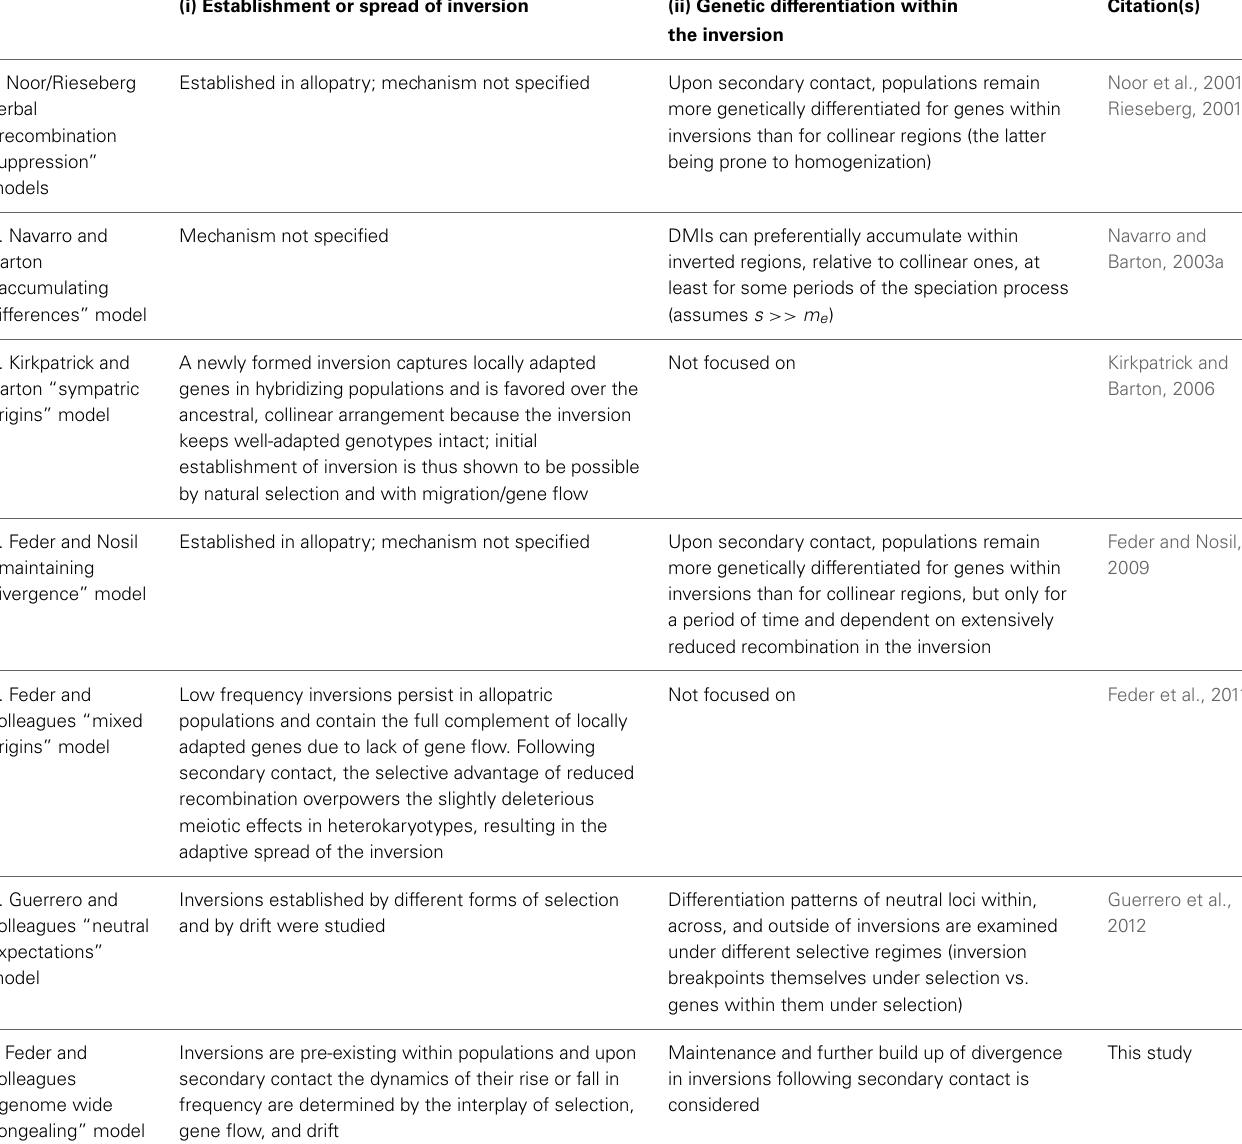
Table 1 | Summary of genic inversion models since 2001, in terms of their consideration of: (i) the initial establishment or spread of the inversion, and (ii) levels of genetic differentiation within the inversion (especially with respect to those observed in collinear regions). (i) Establishment or spread of